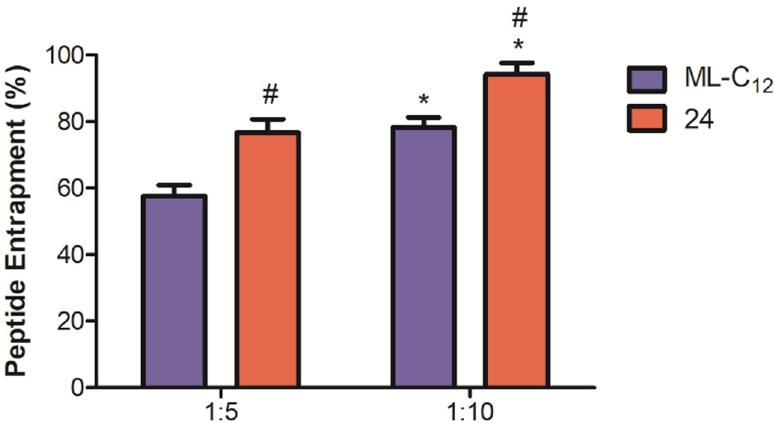
Figure 7 . Glycoliposomal entrapment of Dynantin. Dynantin was combined with 24 or ML-C 12 in water at 1:5 and 1:10 ratios of peptide: glycolipid. The degree of peptide entrapment was analyzed by RP-HPLC in the presence of 0.1% trifluoroacetic acid. The peptide was detected by absorbance at 210 nm and results are represented as the percentage of entrapped peptide relative the amount determined in control samples devoid of glycolipid. Data are shown as the average ± SEM of three separate experiments. # p < 0.05 as compared to ML-C 12 for respective formulation, * p < 0.05 as compared to respective 1:5 formulation.